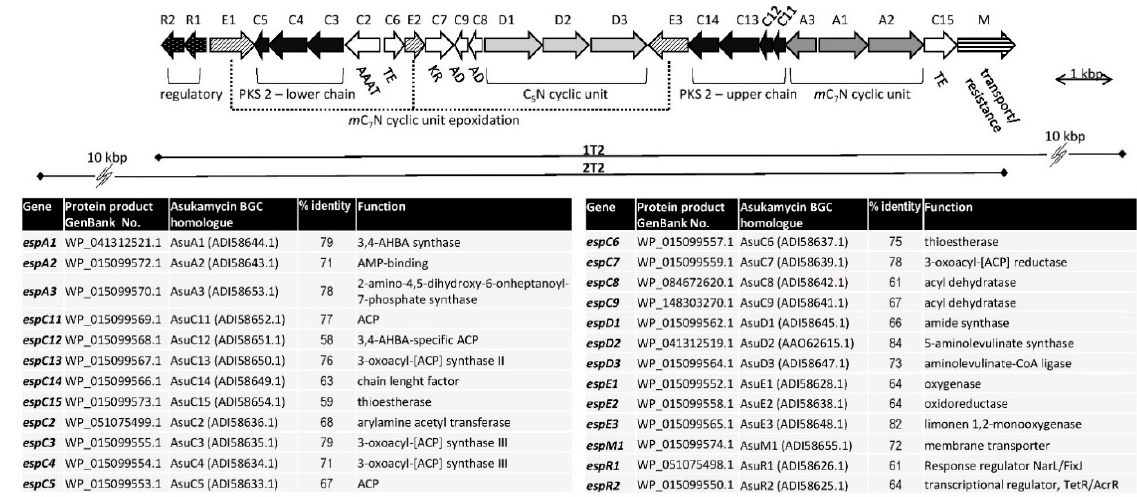
Figure 2. Manumycin-type gene cluster of Saccharothrix espanaensis DSM44229. The genes were assigned by homology to the genes of the asukamycin biosynthetic gene cluster (BGC) in Streptomyces nodosus ssp. asukaensis ATCC 29757, GenBank: GQ926890.1 [28]. The gene functions and homology to asukamycin biosynthetic genes are listed in the table below. 1T2 and 2T2 cosmid clone inserts extents are indicated.